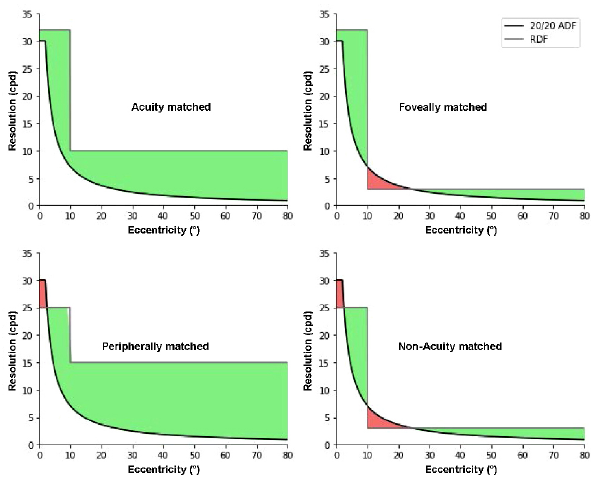
Four possible comparisons of the user’s visual acuity distribution function and the display’s resolution distribution function. Reproduced with permission from Ref. [98], c (cid:13) IEEE